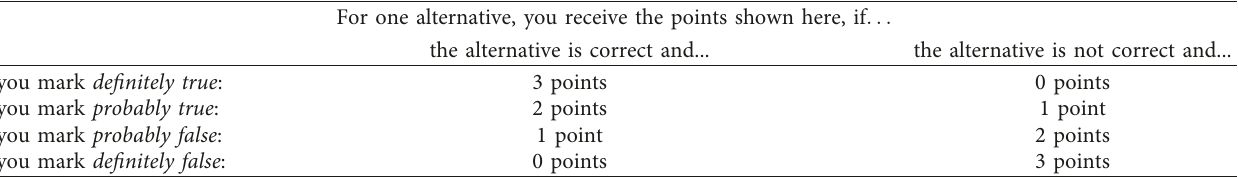
Table 2: Overview of scoring an alternative in the 2014 additional questions. The same table (in German) was made available to students three and a half months prior to the